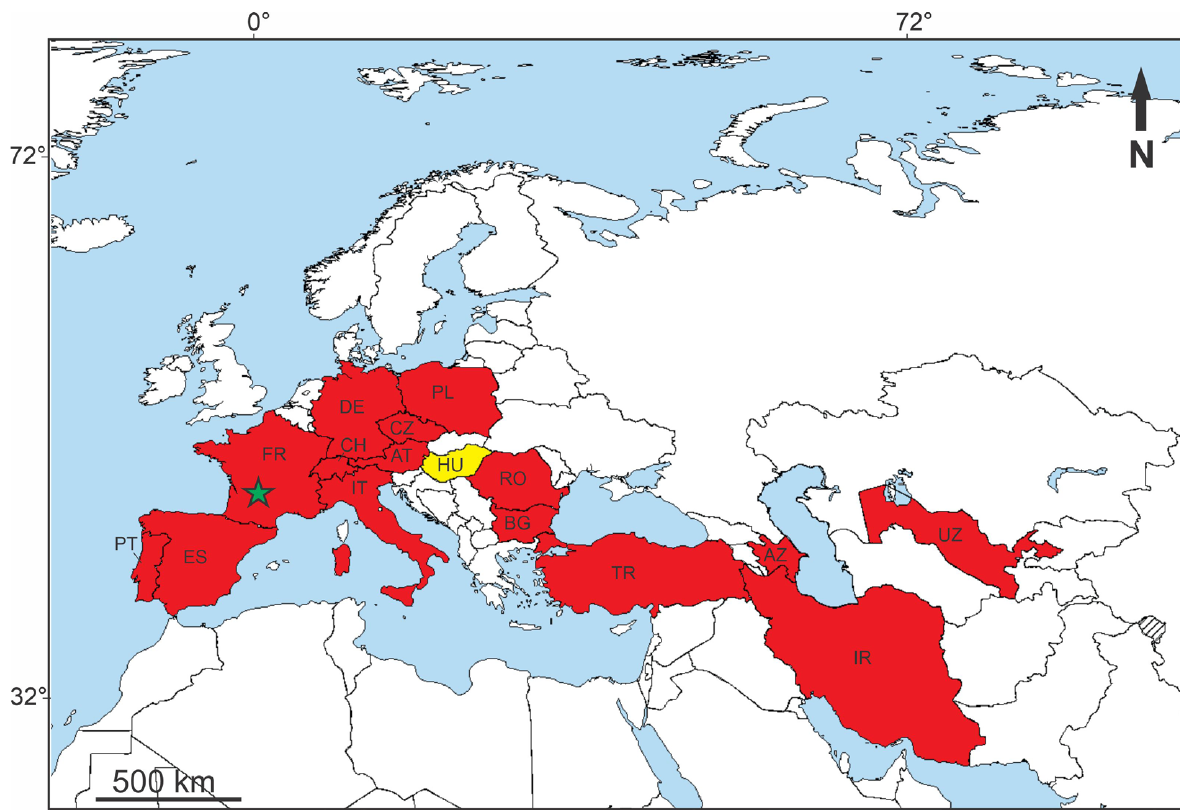
Figure 4. Distribution of A pocheiridium ferum in Europe, the Caucasus, the Middle East, and Central Asia (red fill = published distribution, yellow fill = new distribution in Hungary). Green star = type locality in